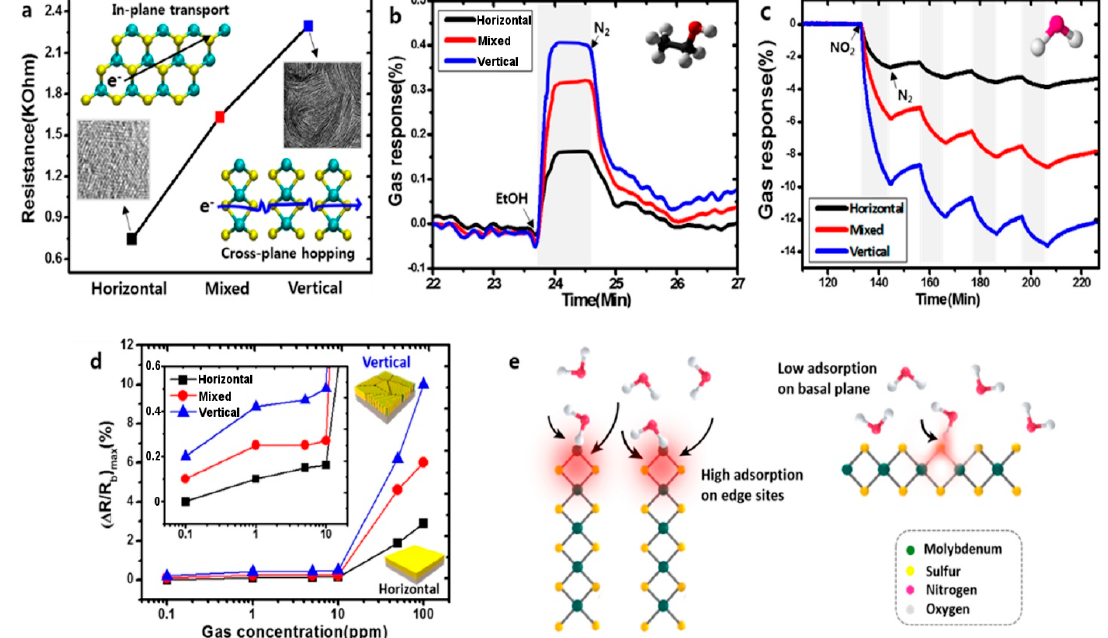
Figure 16. Panel ( a ): vertically aligned MoS 2 flakes have higher resistance due to cross-plane hopping of the carriers; Panel ( b ): resistance change to 1000 ppm of ethanol for horizontally (black curve), vertically (blue curve) and mixed aligned MoS 2 flakes; Panel ( c ): resistance change to 100 ppm of NO 2 for horizontally (black curve), vertically (blue curve) and mixed aligned MoS 2 flakes; Panel ( d ): relative resistance change of the horizontally, vertically and mixed aligned MoS 2 flakes to 0.1–100 ppm NO 2 ; Panel ( e ): schematic representation of the adsorption of NO 2 molecules on edge sites and basal plane of the MoS 2 flakes. (Reproduced with permission from [173]. Copyright 2015 American Chemical Society, Washington, DC, USA).